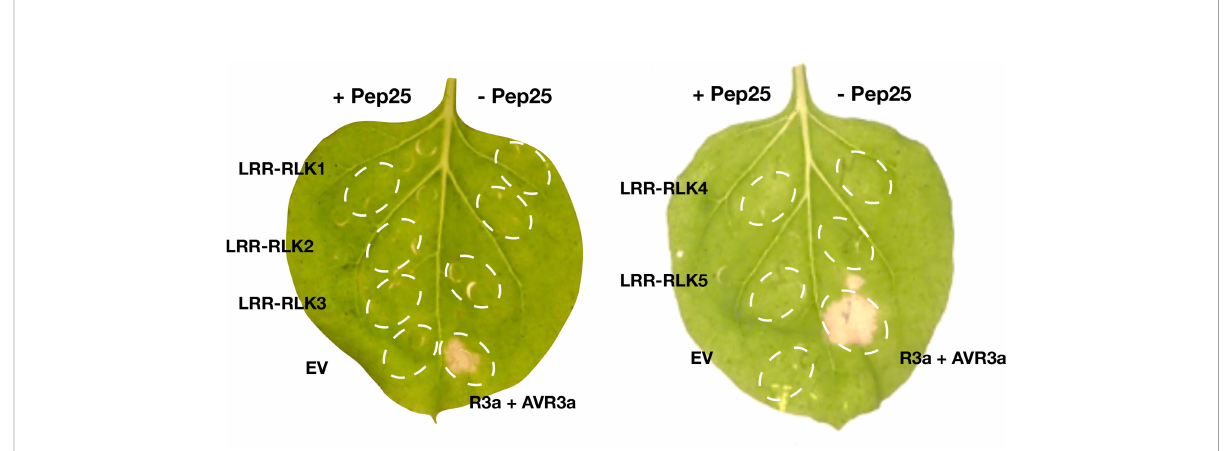
FIGURE 4 Complementation study of candidate genes. The fi ve candidate genes of the Pep-25 receptor ( LRR-RLK1 , LRR-RLK2 , LRR-RLK3 , LRR-RLK4 , LRR- RLK5 ) were agroin fi ltated in N. benthamiana leaves, OD 600 = 1.0, and Pep-25 peptides (2 m M) were in fi ltrated 2 days later. The photos were taken 3 days after the peptides in fi ltration. Co-agroin fi ltration of R3a and AVR3a were used as a positive control, empty vector and Pep-25 were used as a negative